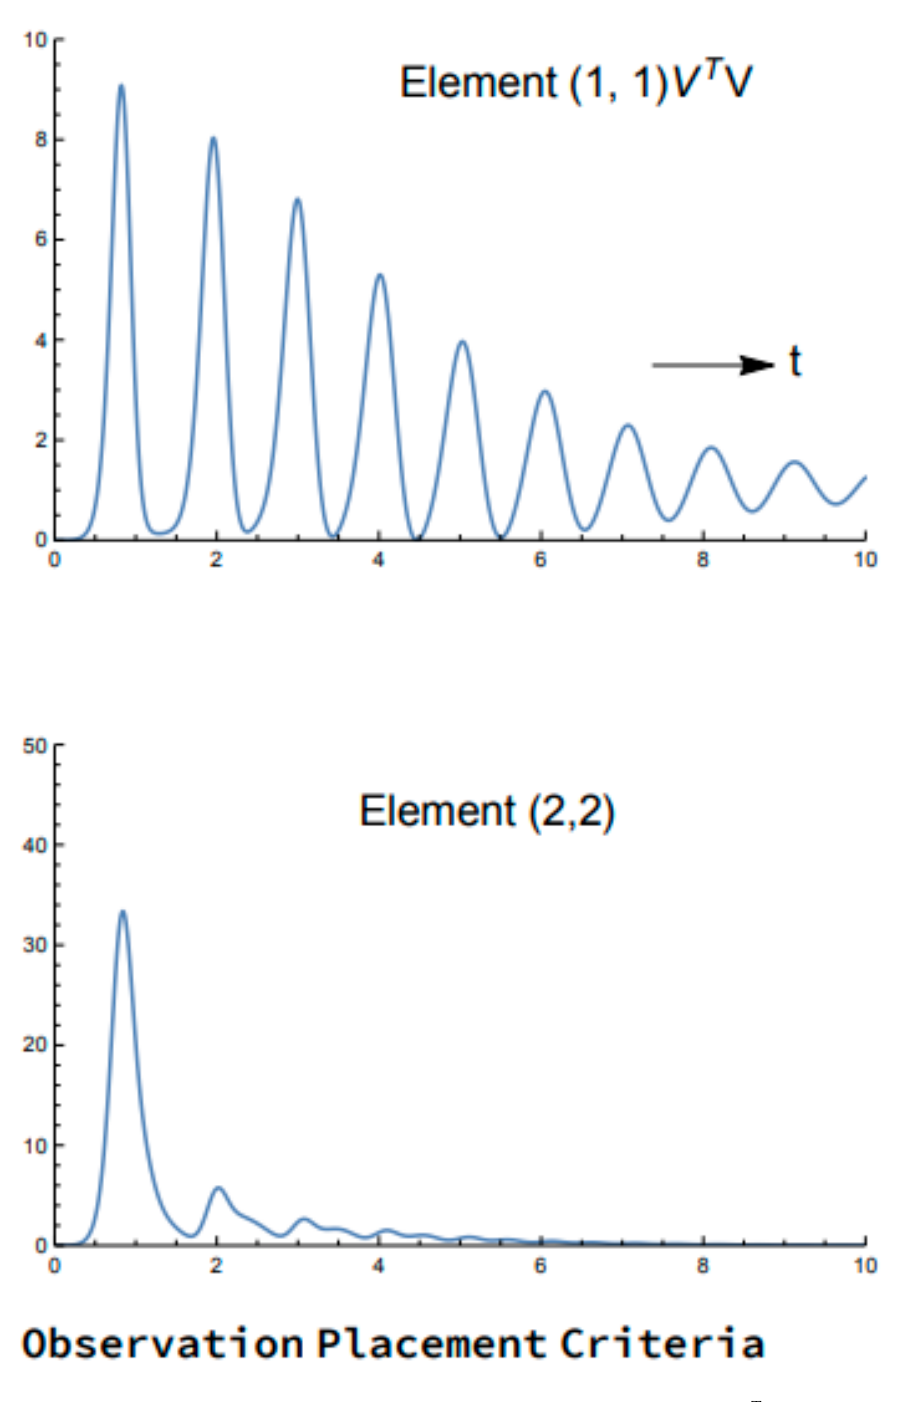
Figure 8. Plots of the diagonal elements of the product sensitivity matrix V T V —elements (1,1) and (2,2)—for the nonchaotic regime using L-LOM (3) when guess controls are given by λ = 12.6, σ = 4.0 .